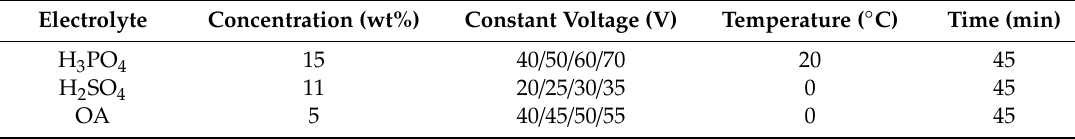
Figure 1. Schematic illustration of ( a ) the superhydrophobic surface, ( b ) the coating geometric model, ( c ) Cassie–Baxter model, ( d ) the schematic of fabricating the superhydrophobic surface. Table 1. Electrolytes and parameters in the anodizing